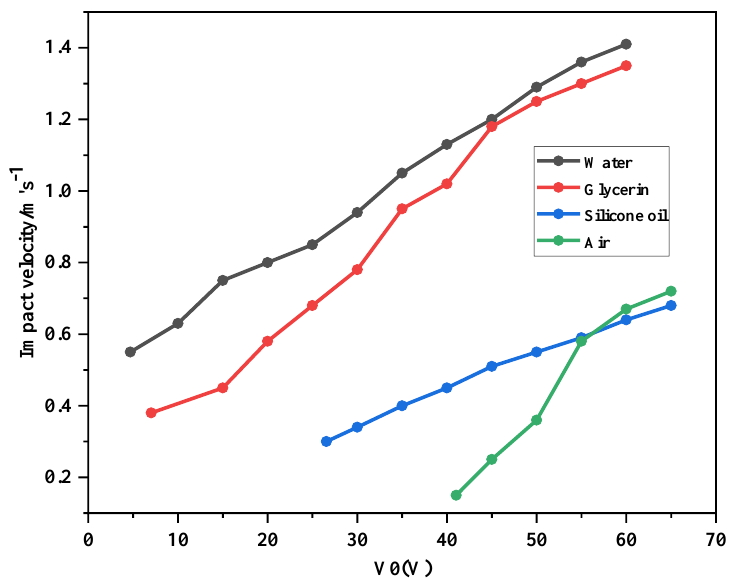
Figure 7. Curves of relation between impact velocity and driving voltage of different material filled switches.